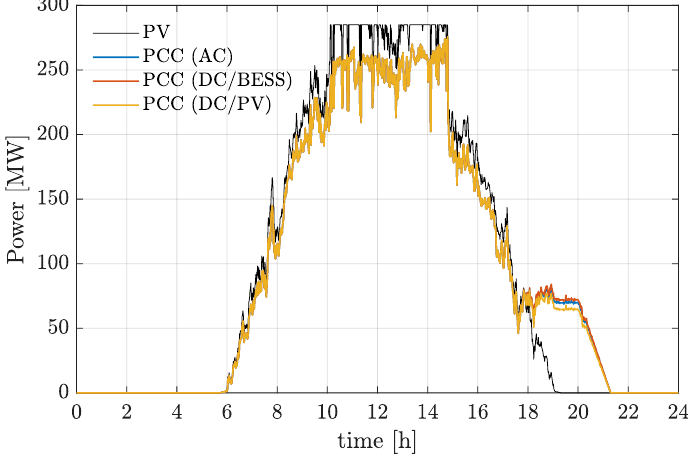
Figure 9. Delivered grid power of the three different layouts during one typical summer